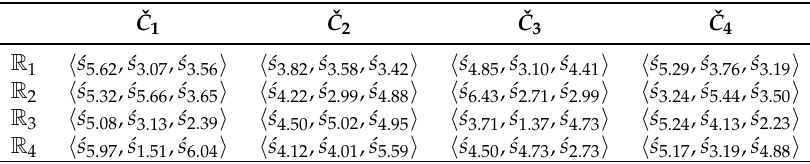
Table 4. Aggregated value of R by utilizing the LSFOWA operator.